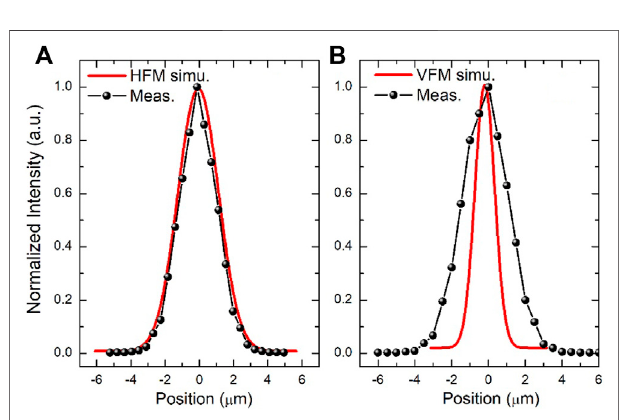
FIGURE 13 | (A) Measured focusing spot of the KB system in a horizontal direction and (B) in a vertical direction.